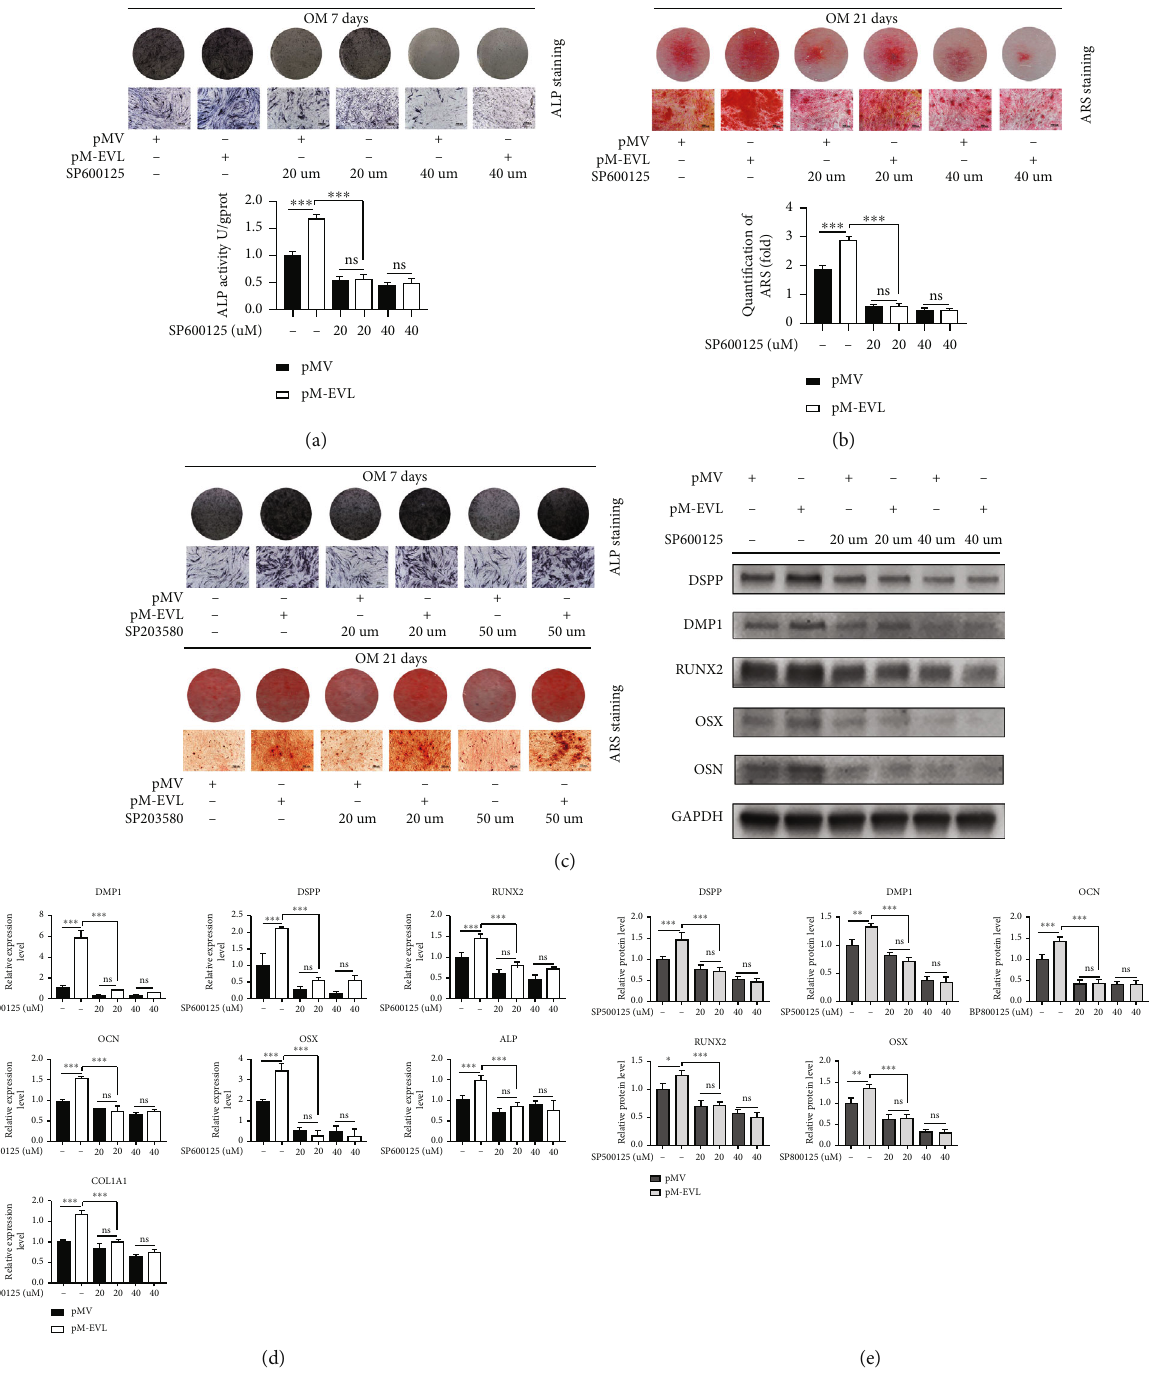
Figure 5: EVL enhanced hDPSCs osteo-/odontogenic di ff erentiation via activating JNK signaling. (a) Pretreatment with 20 or 40 μ M SP600125 for 1h, ALP staining and quantitative intracellular ALP activity were determined in hDPSCs transfected with pM-EVL on the 7th day. (b) Extracellular calcium deposition was visualized by alizarin red staining on the 21st day. Released dye in alizarin red staining was quanti fi ed by measuring absorbance at 562nm. (c) Pretreatment with 20 or 50 μ M SB203580 for 1 h, ALP and ARS staining were determined in hDPSCs transfected with pM-EVL. (d) Pretreatment with 20 or 40 μ M SP600125 for 1 h, the expression of DSPP, DMP1, ALP, RUNX2, OSX, OCN, and COL1A1 is analyzed in hDPSCs transfected with pM-EVL by qRT-PCR on the 7th day. (e) The expression of DSPP, DMP1, RUNX2, OCN, and OSX in hDPSCs transfected with pM-EVL is analyzed by western blot on the 7th day. GAPDH was used as an internal control in qRT-PCR and western blot analyses. Data are shown as the mean ± SD ( n = 3 ); ∗ P ≤ 0 : 05 , ∗∗ P ≤ 0 : 01 , ∗∗∗ P ≤ 0 : 001